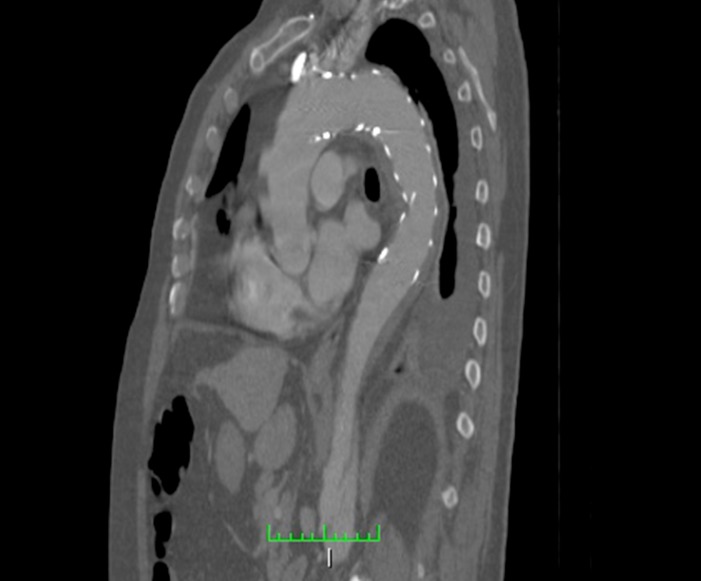
Computed tomography angiography showing that the proximal flap has been sealed.